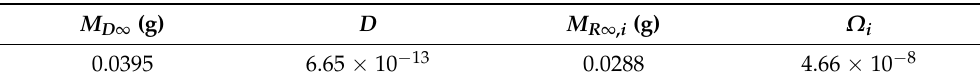
Figure 11. Dual-Fickian numerical model curve and experimental results for the gravimetric analysis in cutting fluid. Table 5. Cutting fluid uptake